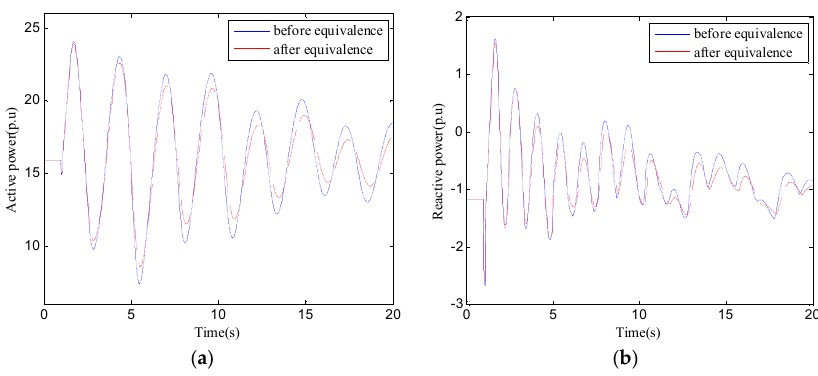
Figure 12. ( a ) Active power curves between before and after equivalence; ( b ) reactive power curves between before and after equivalence.